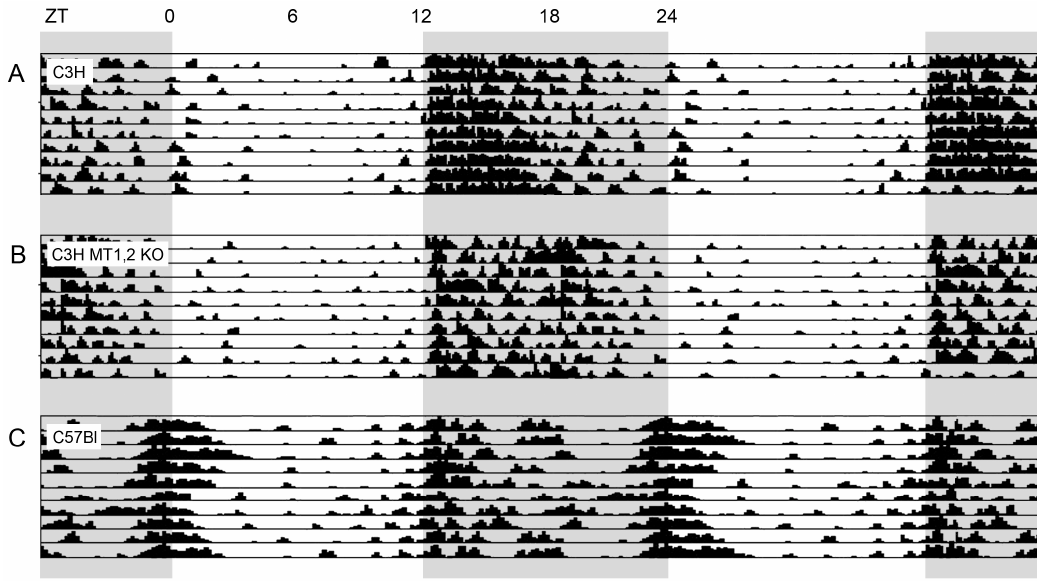
Figure 2. Double plotted actograms of a C3H mouse ( A ); and a MT 1,2 double KO mouse ( B ); and a C57Bl mouse ( C ). Grey indicates darkness.